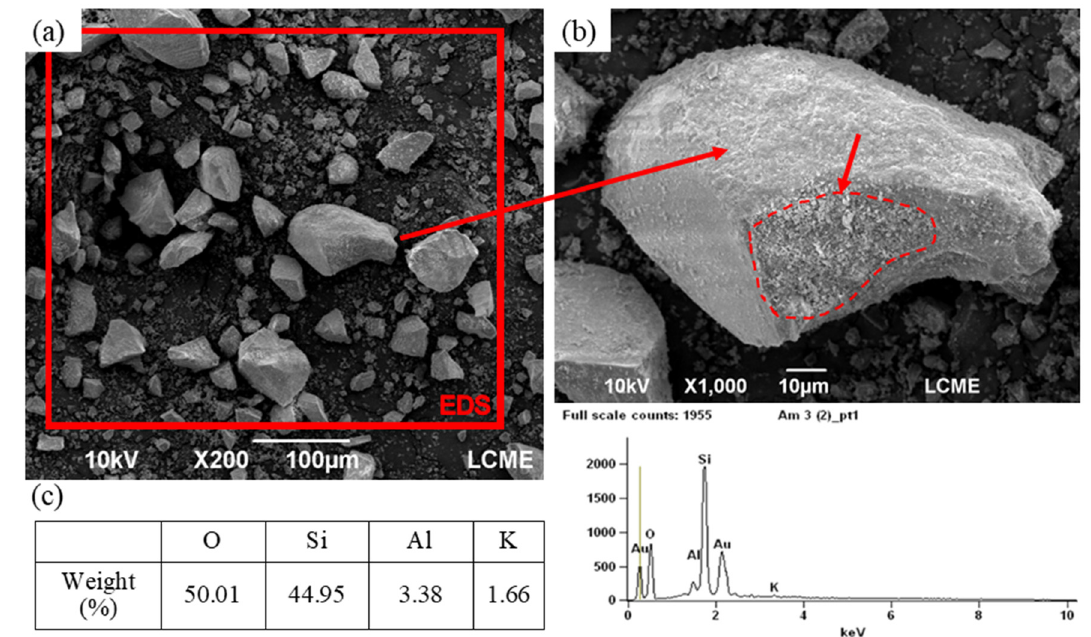
Figure 2. SEM images of the OSW filler at ( a ) ×200 and ( b ) ×1000 magnification, and ( c ) EDS result from OSW filler.